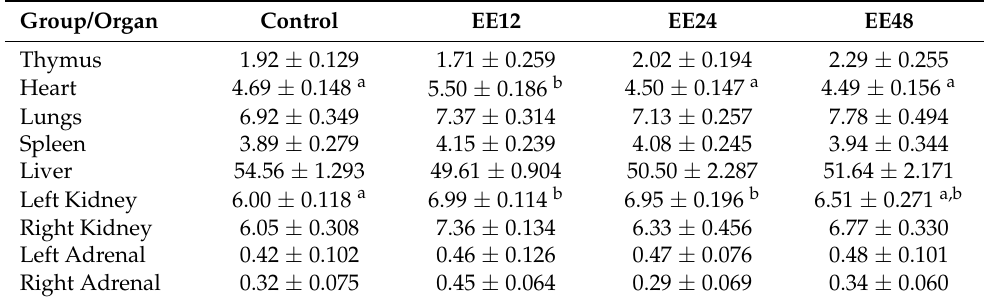
Table 2. Mean ( ± SE) relative organ weights (organ weight (mg)/body weight of the animal (g)) from the experimental groups.